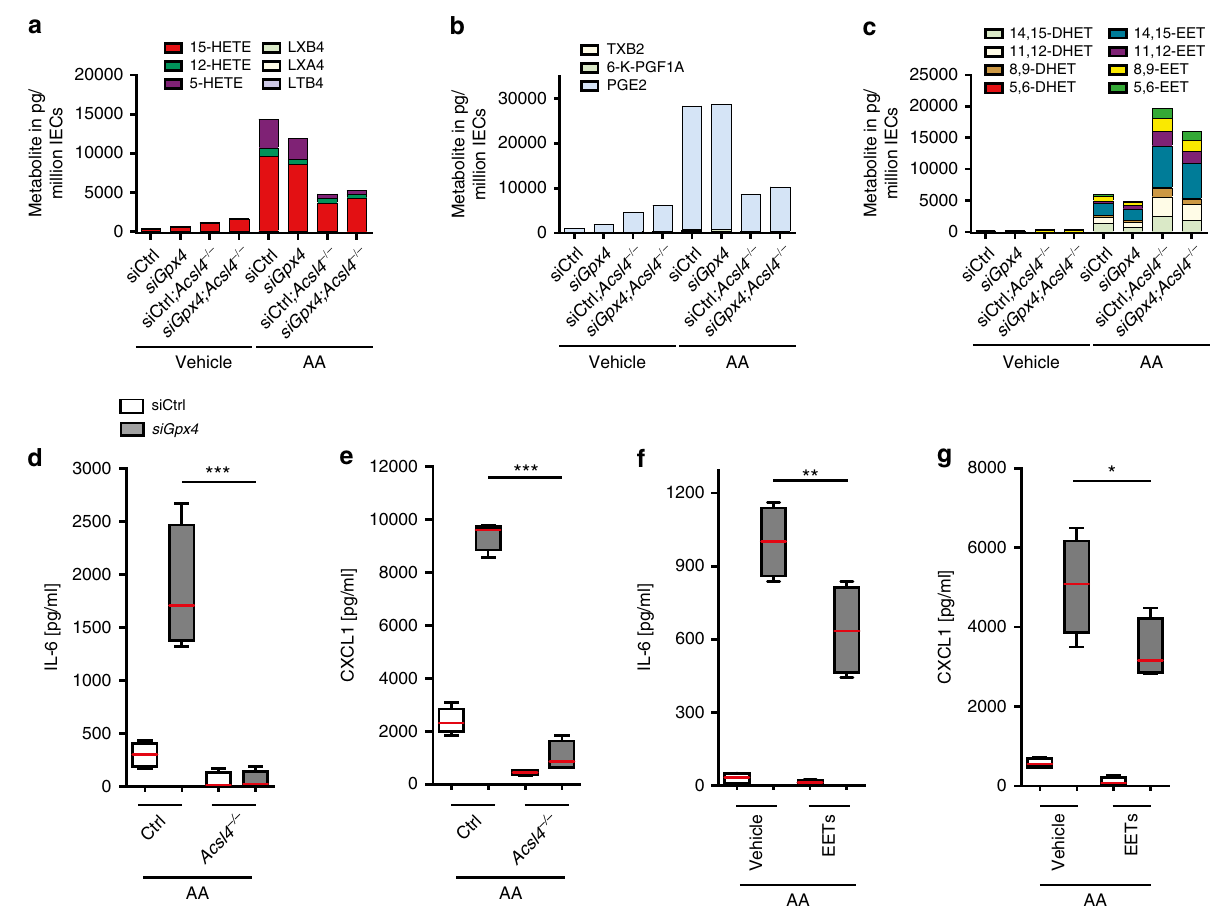
Fig. 6 ACSL4 governs AA-induced cytokine production partly by modulation of AA metabolism. a – c Quanti fi cation of LOX ( a ), COX ( b ), and P450 ( c ) AA metabolites in siGpx4 and siCtrl IECs with or without deletion of Acsl4 and AA stimulation for 24 h. Three independent experiments were performed and pooled for metabolite analysis by LC-MS/MS. d , e Quanti fi cation of IL-6 and CXCL1 in the supernatant of siGpx4 and siCtrl IECs with or without deletion of Acsl4 and AA stimulation for 24 h ( n = 4 biologically independent experiments). *** P < 0.001. f , g Quanti fi cation of IL-6 and CXCL1 in siGpx4 and siCtrl IECs after 24 h AA stimulation co-treated with a combination of EETs (0.25 µ M of ( + / − ) 8(9)-EET, ( + / − ) 11(12)-EET and ( + / − ) 14(15)-EET) ( n = 4 biologically independent experiments). ** P = 0.0011 and * P = 0.0242. For panel ( d – g ) data are presented as boxblot with median and interquartile range (25th and 75th). The whiskers represent minimal and maximal values. One-way ANOVA with Bonferroni ’ s multiple comparison test. Source data are provided as a Source Data fi IL-22 (10ng/ml, PeproTech 210-22), cholic acid (1µM, Sigma C9282), deoxycholic acid (1µM, Sigma D2510), ursodeoxycholic acid (1µM, Sigma U5127),( + / − )8(9)- and ( + / − )11(12)- and ( + / − )14(15)-EETs (0.25µM Cayman Chemicals, 50511, 50651, 50351), ML351 (10µM, Sigma, SML1353), PD146176 (0.5µM, Sigma, P4620), zileuton (10µM, Sigma, Z4277), NCTT-956 (2µM, Sigma, SML0499), pir- oxicam (20µM, Sigma, P5654), 5-HETE (200nM-1µM, Cayman Chemicals, 34210), 15-HPETE (200nM-1µM, Cayman Chemicals, 44720), PGE2 (50ng/ml, Sigma, P0409), BAY117082 (10µM, Sigma, B5556), MG132 (125nM, ApexBio, A2585). siRNA silencing . MODE-K IECs were seeded on 6-well plates at ~70% con fl uence for siRNA silencing with either Gpx4 siRNA ( siGpx4 , Ambion, s122098), Alox12 ( siAlox12 , Ambion, s62261), Alox15 ( siAlox15 , Ambion, s62271) or scrambled control siRNA (siCtrl, Ambion 4390843) and RNAiMAX (Thermo Fisher Scien- ti fi c, 13778100) transfection over 48h unless otherwise indicated, according to the recommended protocol. CRISPR Cas9 gene editing . Target genes were disrupted in MODE-K IECs using the CRISPR/Cas9 system 26 . For each gene three guide RNAs (gRNA) targeting different exons of the target gene were designed. gRNAs with speci fi c overhangs were annealed into a BsmBI-digested plentiCRISPRv2 plasmid (Addgene #52961, gift from Feng Zhang) 57 . Vectors were transfected into HEK293T cells (ATCC ® CRL-1573 ™ ) to produce viral particles. Harvested supernatants were used for gene knockout. For transfection, MODE-K cells were seeded on 6-well plates and infected with viral particles containing the constructed vectors. The guide RNA sequence used for studies in Gpx4 -/- IECs was CGTGTGCATCGTCACCAACG,